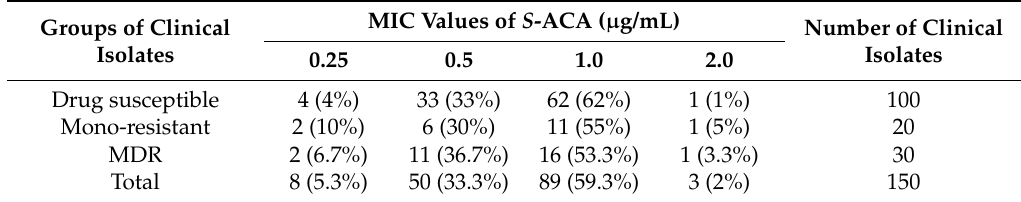
Table 2. MICs of S -ACA against 150 clinical M. tuberculosis isolates obtained from Ramathibodi Hospital. MDR,